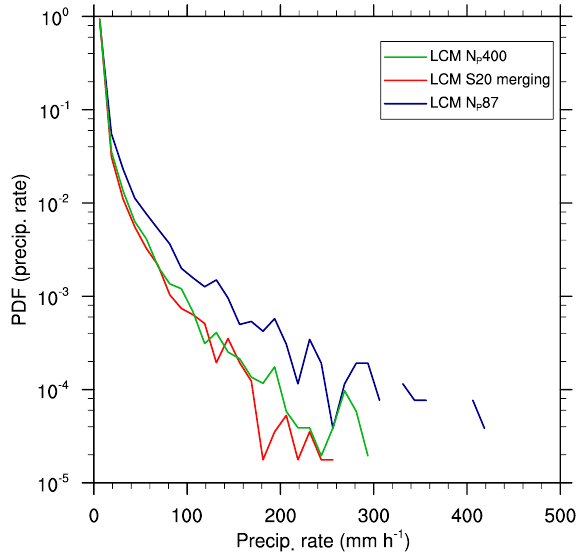
Figure 18. Probability density function of precipitation rates for dif- ferent initial numbers of superdroplets and splitting